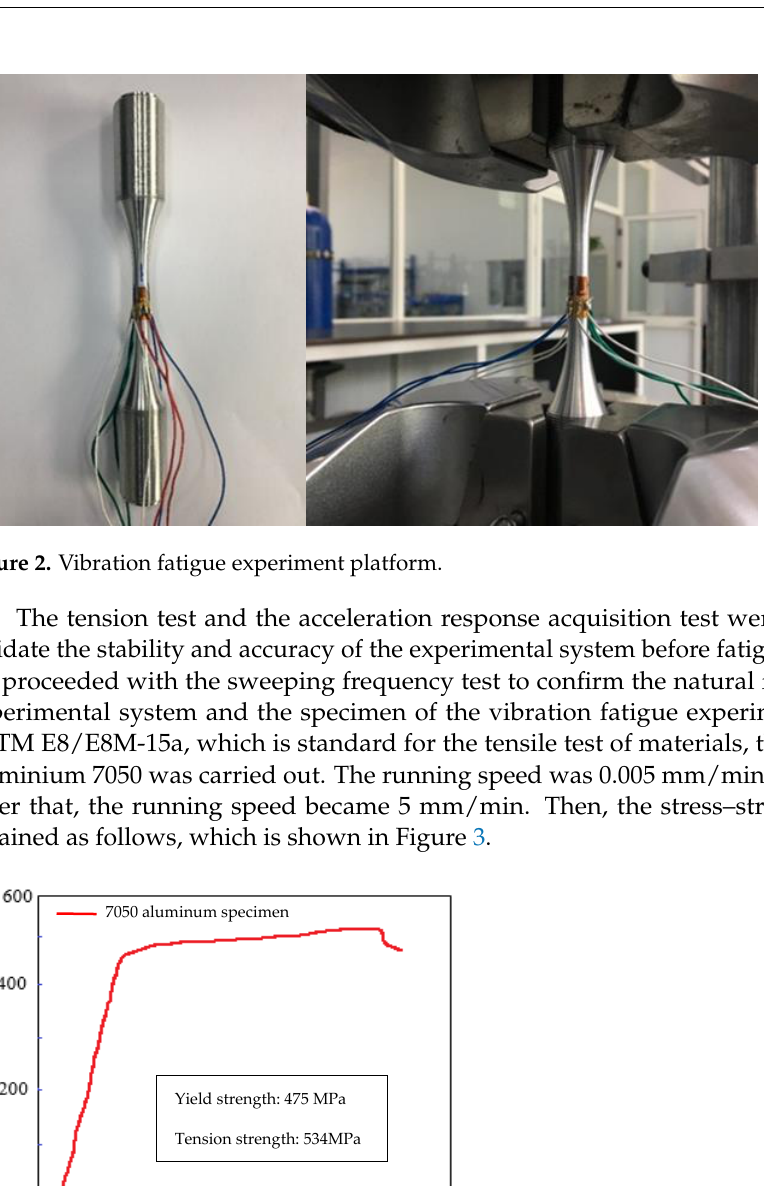
Figure 3. Stress – strain curve of aluminium alloy 7050.